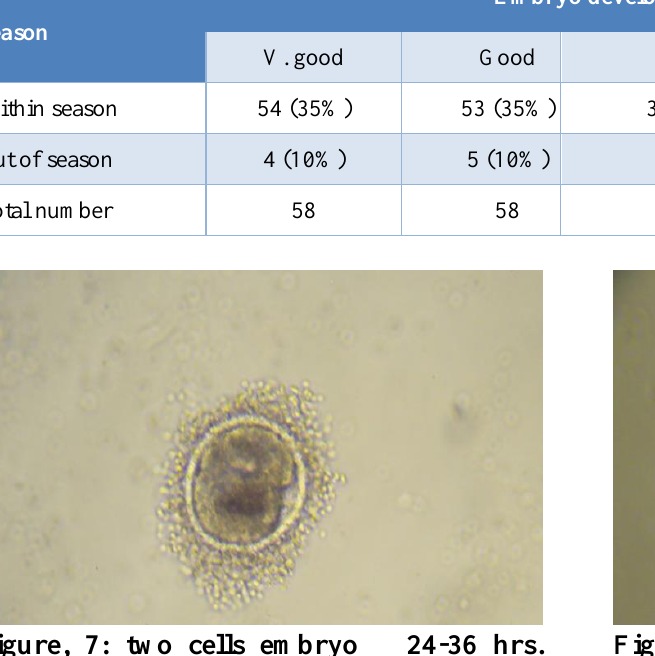
Figure, 8: Four cells embryo 36-48 hrs. after